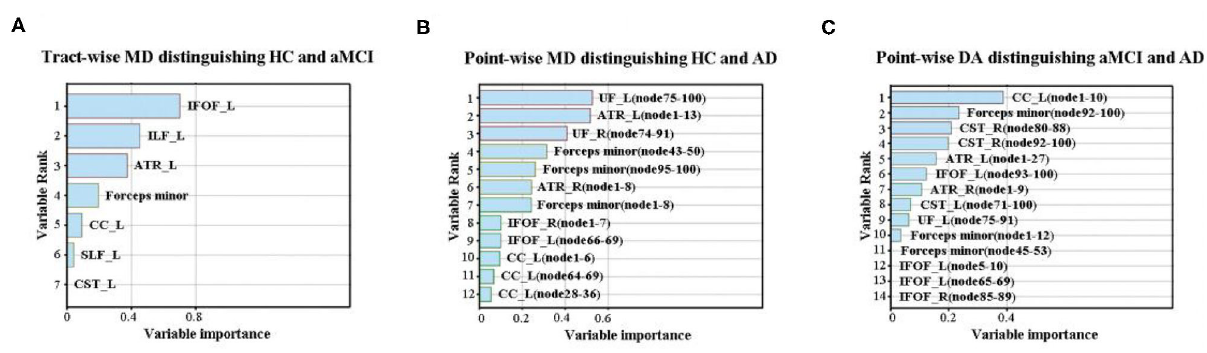
FIGURE 2 | The variable importance of disease diagnosis. (A) The tract-level MD profile distinguished aMCI from HC with discrimination ability (accuracy = 75.51%; sensitivity = 80.00%; specificity = 80.83%). The left IFOF was the most important tract contributing to HC VS. aMCI classification. (B) With respect to differentiating AD from HC, the point-wise MD measurements presented the best classification performance (accuracy = 86.05%; sensitivity = 92.00%; specificity = 77.78%). The two most important variables were localized mainly in tracts along the left UF and ATR. (C) The point-wise DA measurements distinguished AD from aMCI